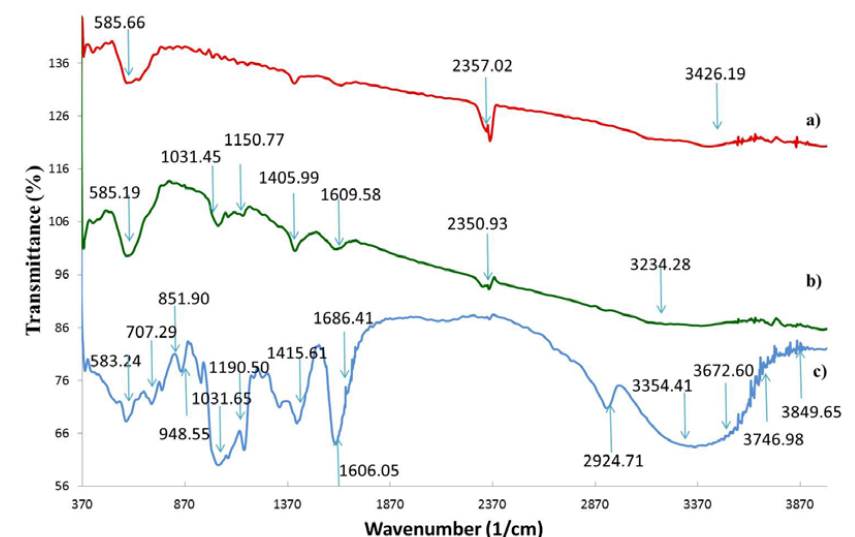
Fig. 2. DLS plots of the (a) naked and (b) β−CD modified Fe Fig. 2 DLS plots of the (a) naked and (b) β− CD modified Fe 3 O 4 nanoparticles.